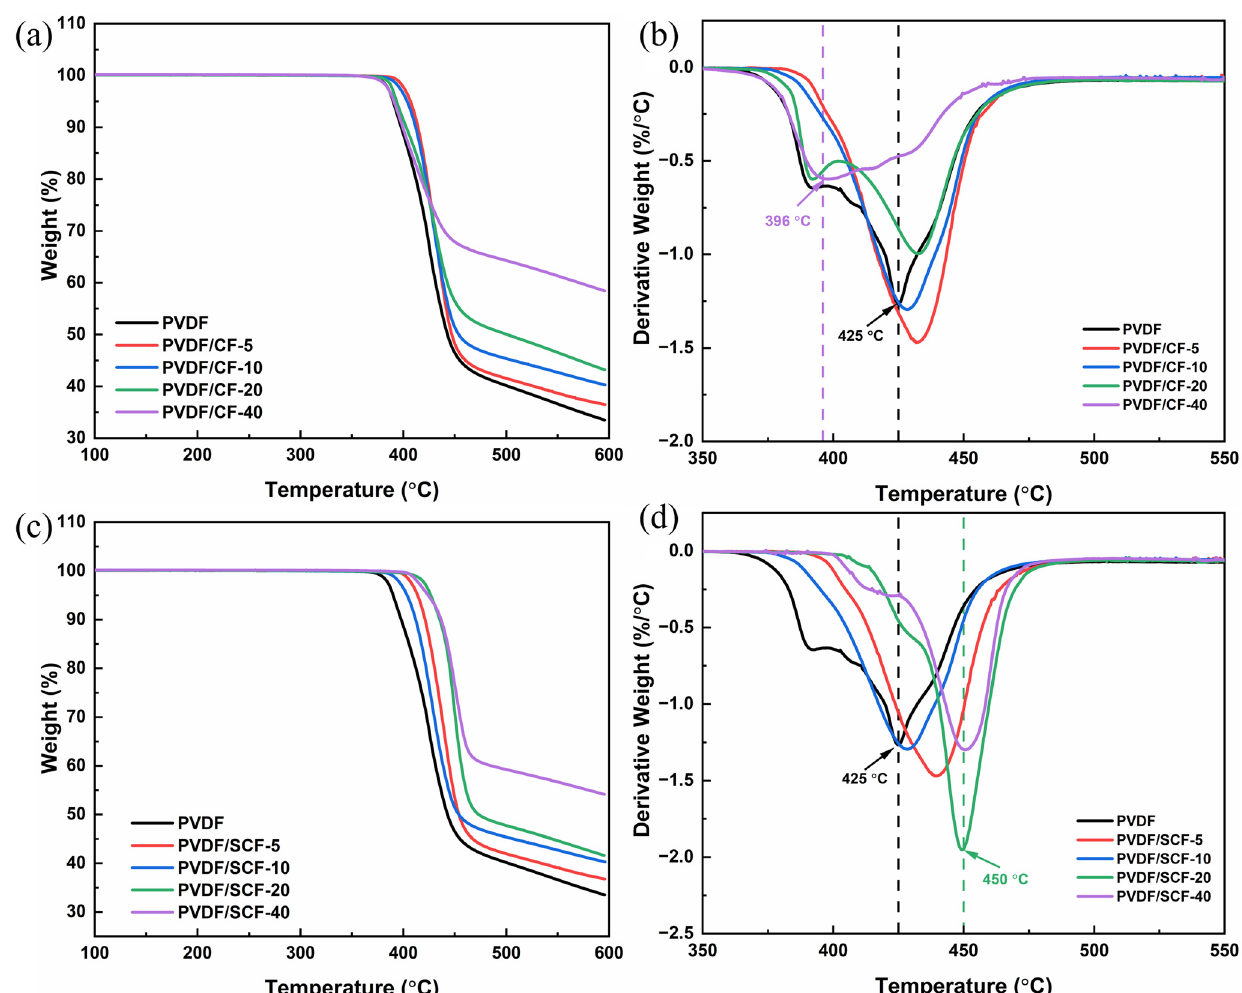
Figure 8. Thermal stability analysis of the pure PVDF and PVDF composites ( a , c ): TGA curves of the PVDF/CF and PVDF/SCF composite series, ( b , d ): DTG curves of the PVDF/CF and PVDF/SCF composite series. Table 3. Degradation properties of the pure PVDF, PVDF/CF, and PVDF/SCF composites.